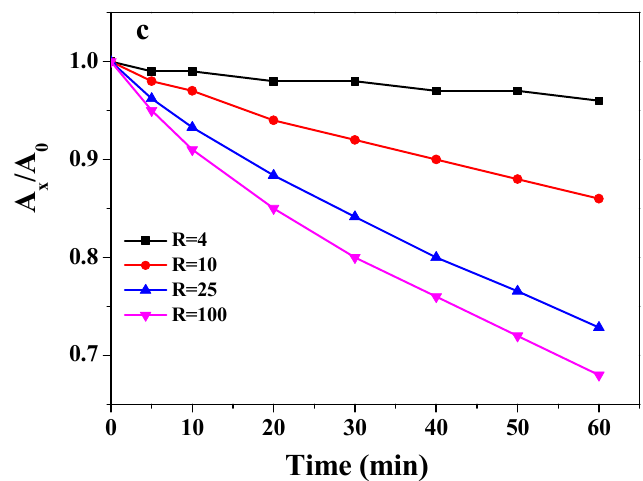
Figure 8. UV-visible absorption spectra ( a ) and fluorescence emission spectra ( λ ext = 430 nm) ( b ) of ZnTPP and AuNPs in complex micelles with different R (R = 100, 25, 10, and 4). ( c ) Kinetic profiles of the photodegradation of ZnTPP and AuNPs in the complex micelles with different R values.